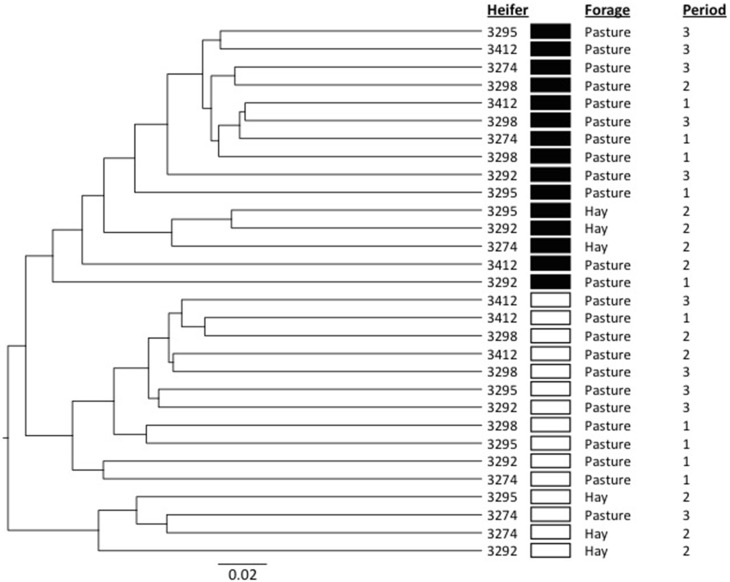
Dendrogram showing the relationships among the bacterial communities as determined by 454 pyrosequencing. The dendrogram was constructed using the Unweighted Pair Group Method with Arithmetic Mean (UPGMA) algorithm and Bray-Curtis calculation for determining the distance between communities. Filled boxes indicate samples from the solid phase of rumen contents while hollow boxes indicate samples from the rumen liquid. Subsampling was performed to normalize among the samples.